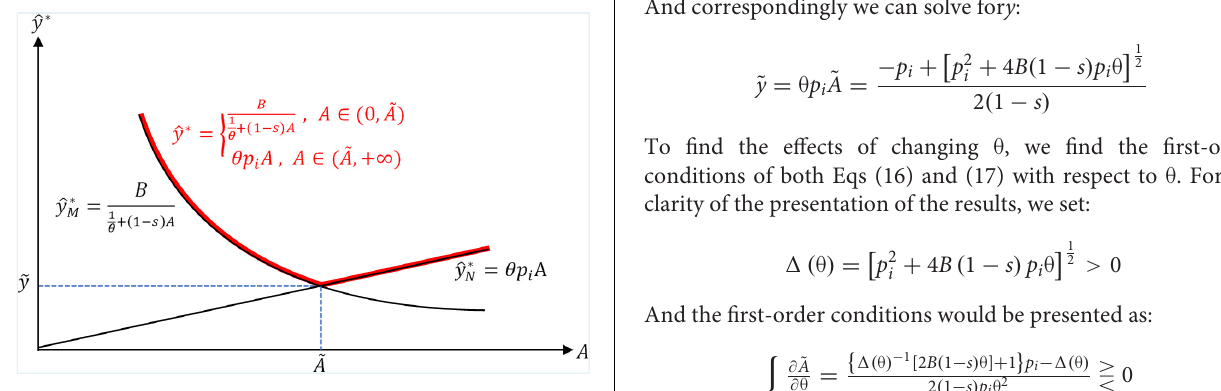
FIGURE 4 | Long-run convergence of equilibrium.